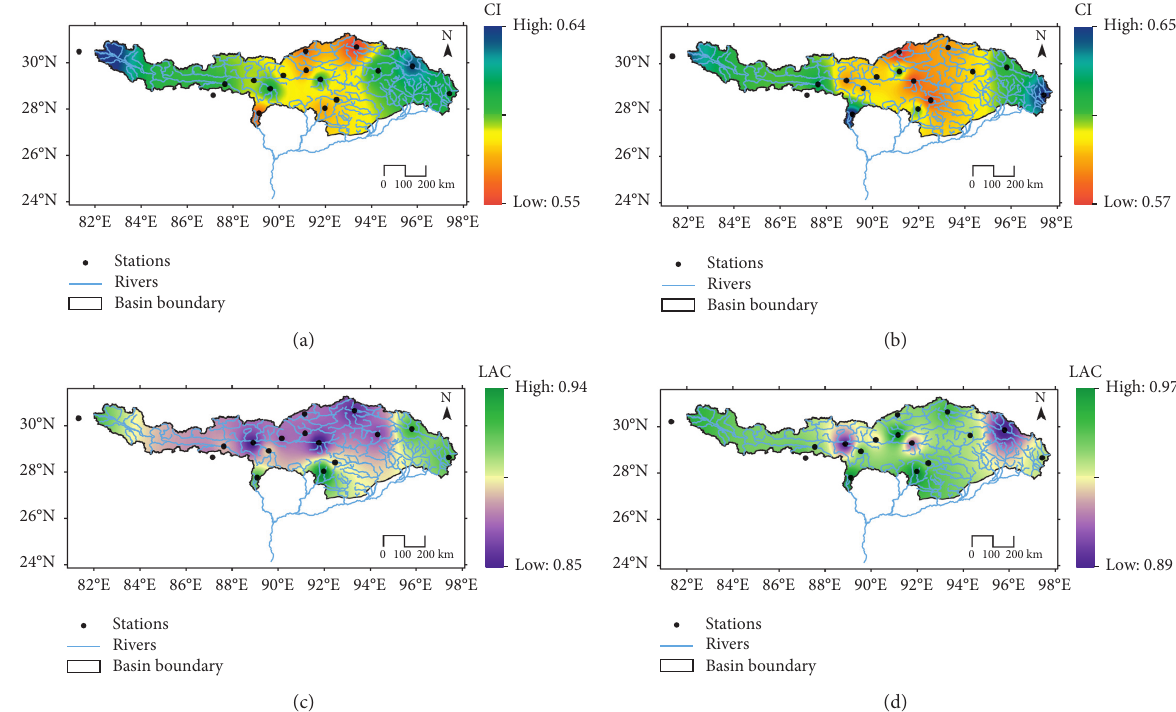
Figure 4: The spatial distribution of the CI and LAC in the wet season and dry season. (a) CI in the wet season; (b) CI in the dry season; (c) LAC in the wet season; (d) LAC in the dry